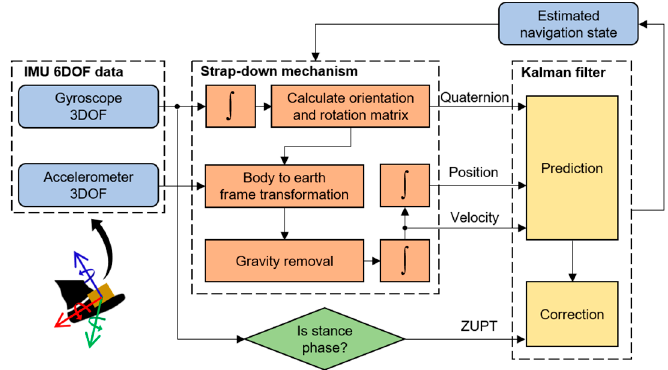
Figure 6. A typical ZUPT-assisted IMU navigation system.